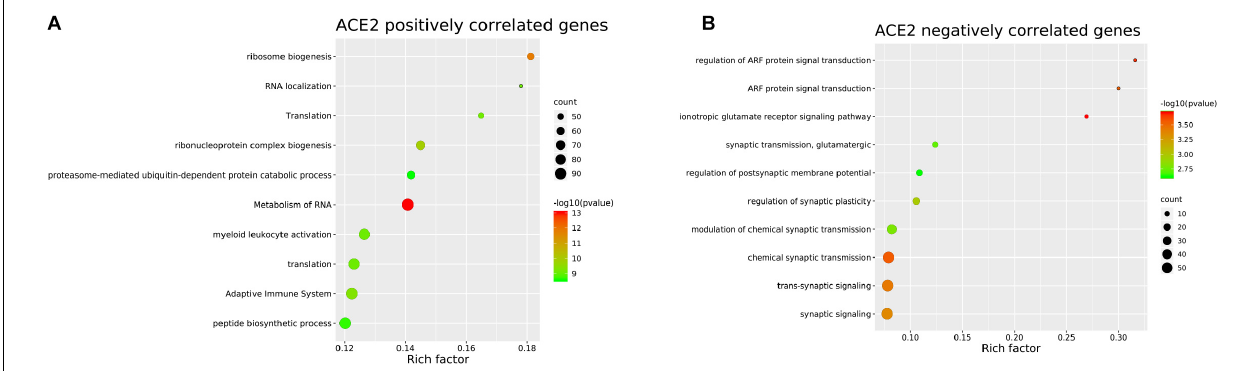
FIGURE 7 | Pathway and process enrichment of the genes co-expressed with ACE2 in lung. (A) ACE2 positively correlated genes. (B) ACE2 negatively correlated genes. The colors of the nodes are illustrated from red to green in descending order of -Log10 ( p Value). The sizes of the nodes are illustrated from small to big in ascending order of gene counts. The horizontal axis represents the rich factor, the vertical axis represents the GO or KEGG terms.